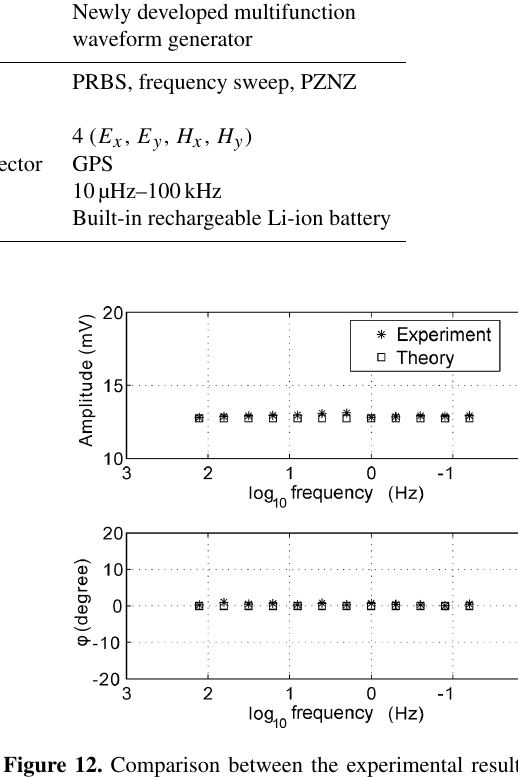
Figure 12. Comparison between the experimental results and the theoretical simulation results for the SIP mode.